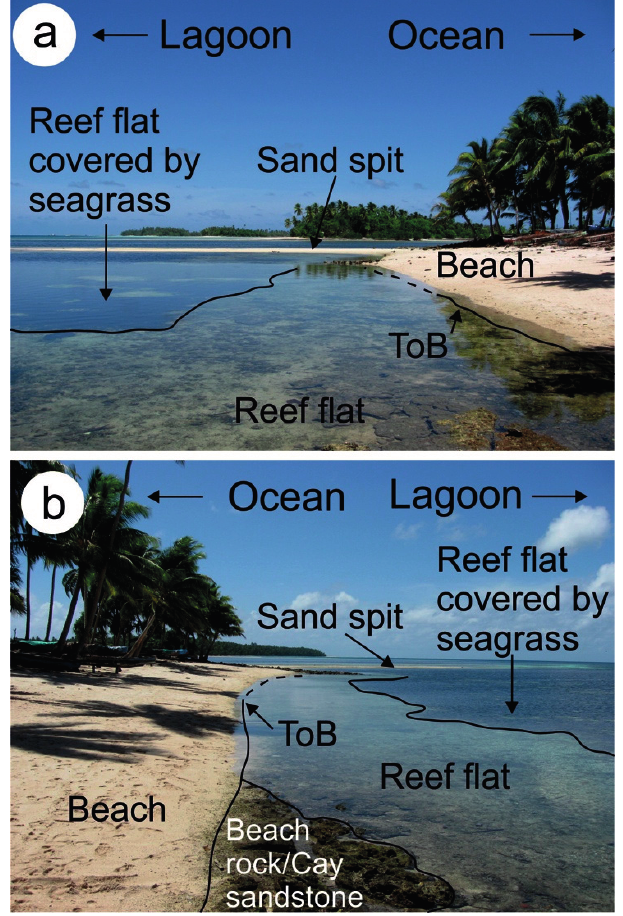
Figure 4. ( a , b ) Morphological elements at the transition from the reef flat to the reef island on Takú Atoll. Photos courtesy of John R.